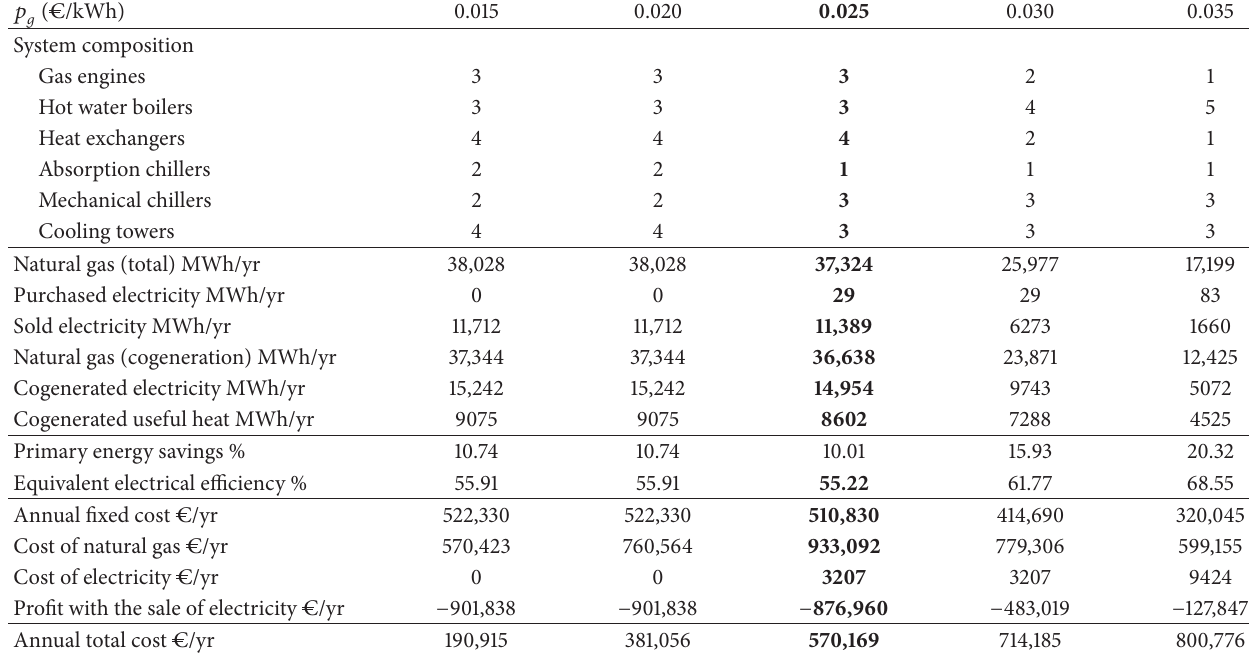
Table 7: Sensitivity analysis for natural gas